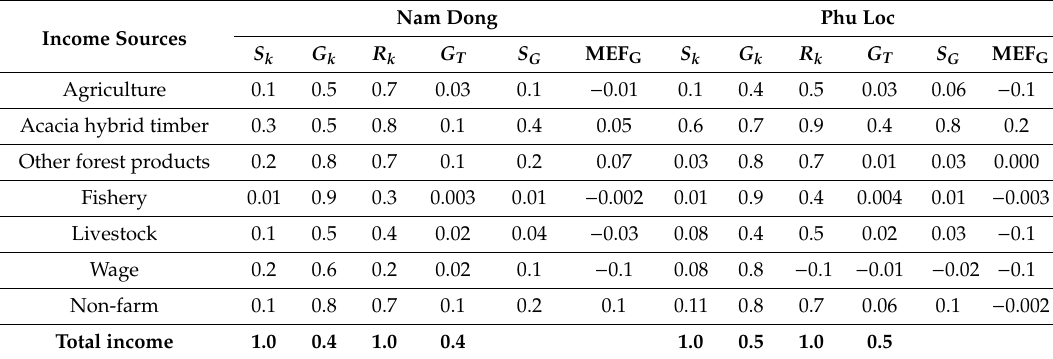
Table 8. Gini decomposition by income sources in Nam Dong and Phu Loc